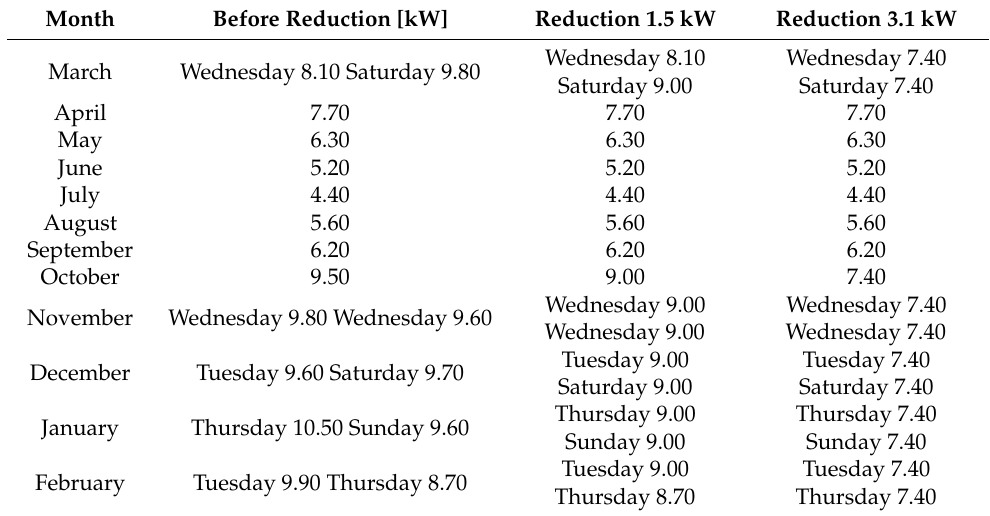
Table 2. Maximum power output before and after reduction of the power peak for high power houses.